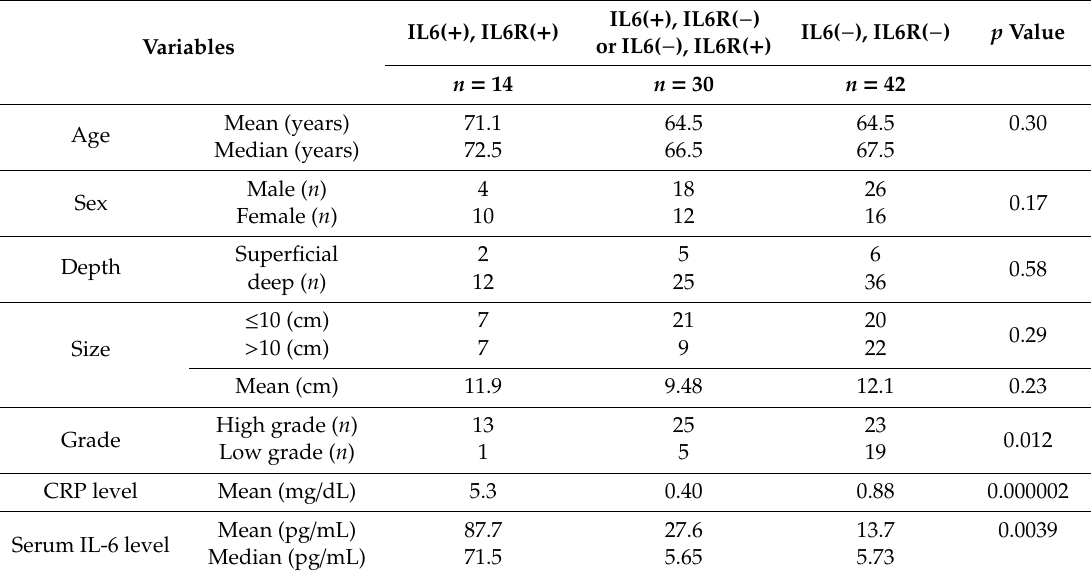
Table 2. Clinicopathological data of soft tissue sarcoma (STS) patients classified by IL-6 and IL-6R expression in